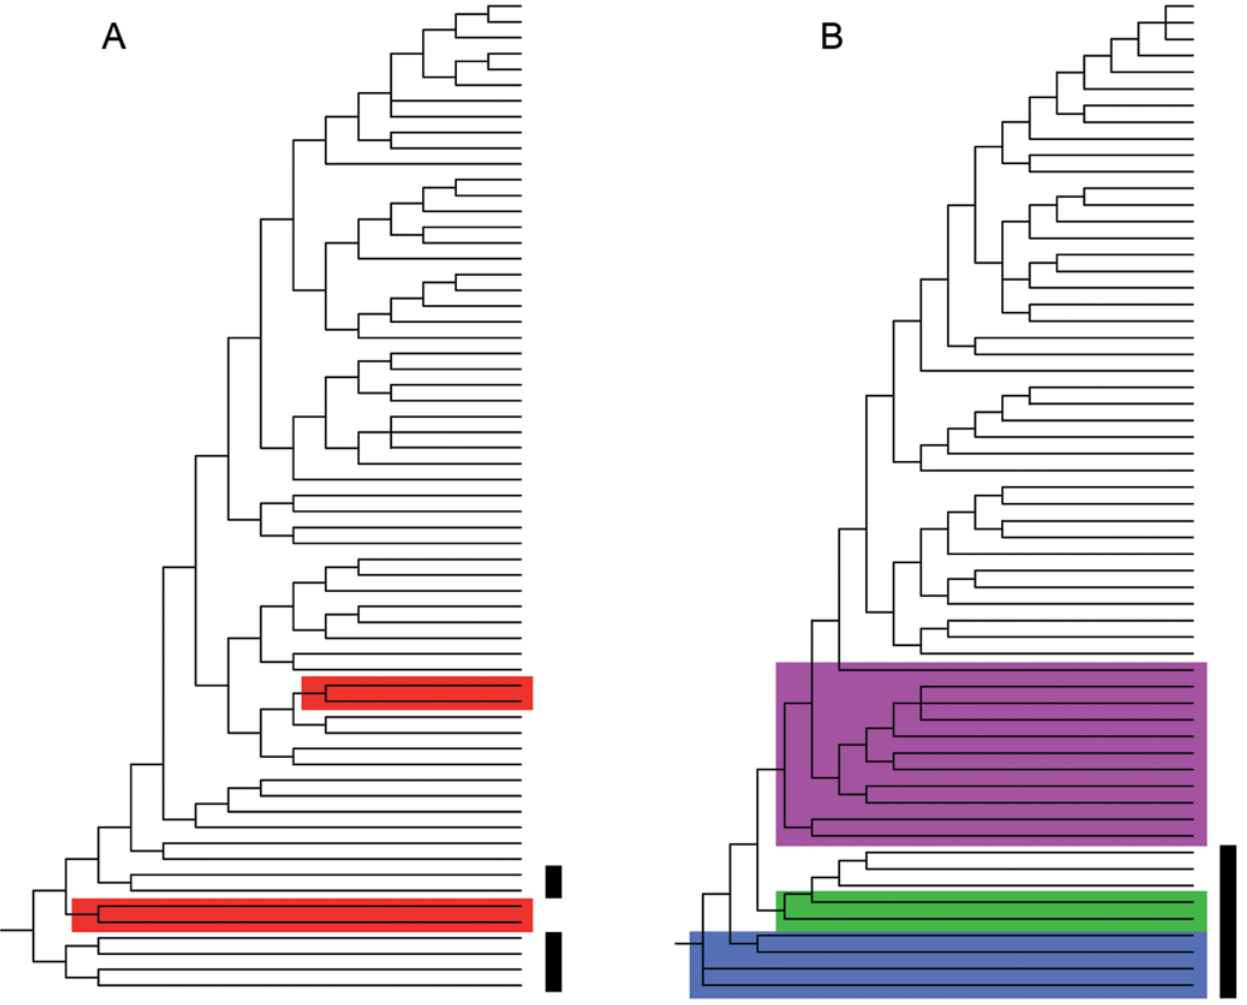
Figure 2. Two analyzed phylogenetic trees, redrawn unlabeled and with uniform internodal distances. A) Fig. 7 from [24]; B) Fig. 1 from [25]. Ingroup taxa are Arachnida and Pectinidae, respectively. Outgroup taxa are marked by thick vertical lines. Basal non-monophyletic taxa are highlighted. The few data points below the diagonal (indicated by arrows) represent trifurcations in both trees. These non-bifurcating nodes indicate unresolved nodes, the tree-building algorithm being unable to select one of two or more competing hypothesis about binary branching pattern for the three lineages involved. These three-stem nodes are not hypotheses of real multifurcation, being instead purely artifactual.